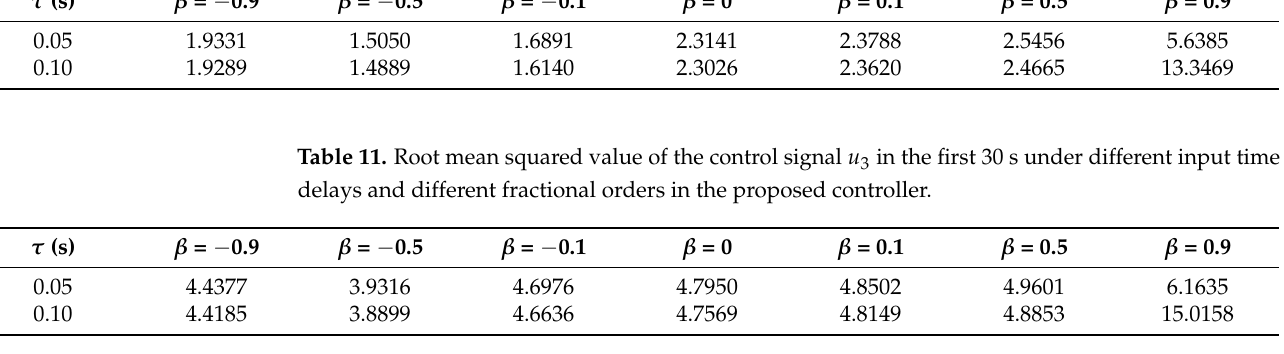
Table 10. Root mean squared value of the control signal u 2 in the first 30 s under different input time